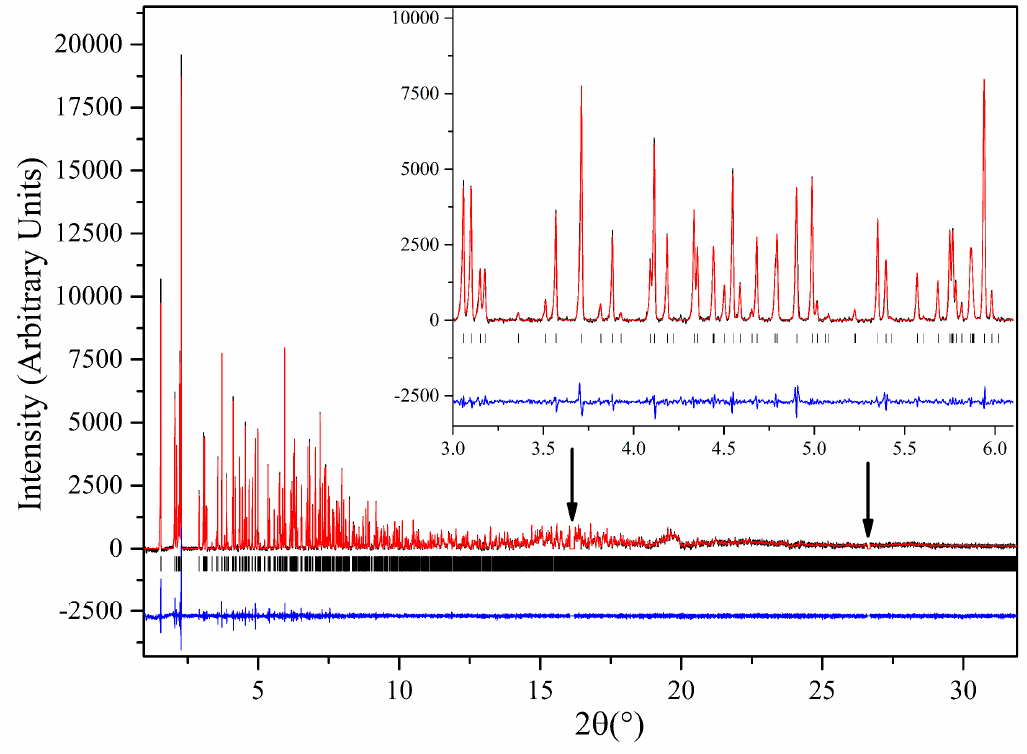
Figure 4. Pawley fit of the synchrotron XRPD profile of CVB3 3C pro (pH 7.50; space group C 2, a = 78.1880 (7) Å, b = 65.5013 (4) Å, c = 40.3104 (6) Å, β = 115.4490 (9) ◦ , R wp = 2.274% and χ 2 = 2.203). Data were collected on MS-X04SA-SLS (RT, λ = 1.300429 (6) Å). The black, red and blue lines represent the experimental data, the calculated pattern and the di ff erence between the experimental and calculated profiles, respectively. The vertical bars correspond to Bragg reflections compatible with space group C 2 and the arrows indicate the improvement in d-spacing resolution (unpublished